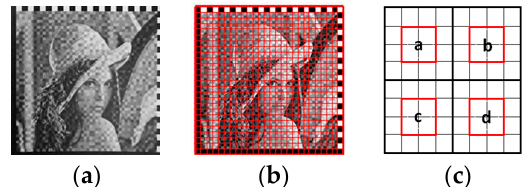
Figure 7. Corrected grayscale image and decoded grids. ( a ) Corrected grayscale image. ( b ) Corrected grayscale image with decoded grids. ( c ) The scheme of decoded grids.